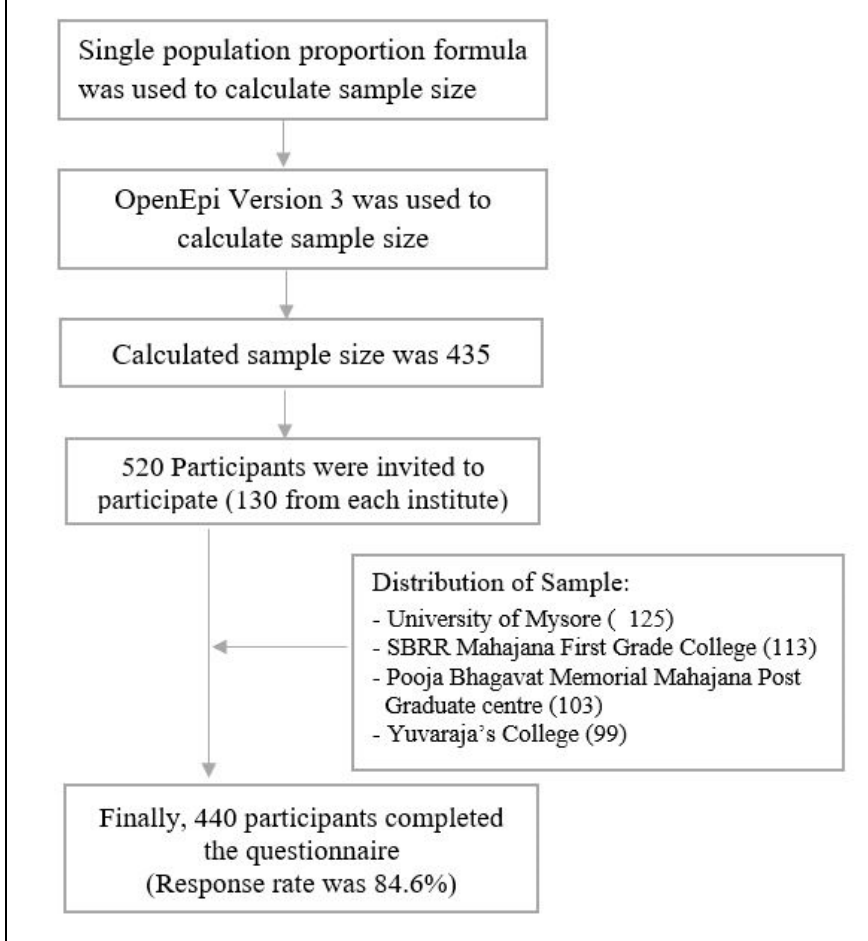
Figure 2. Flow chart of the sampling technique and participants selection.